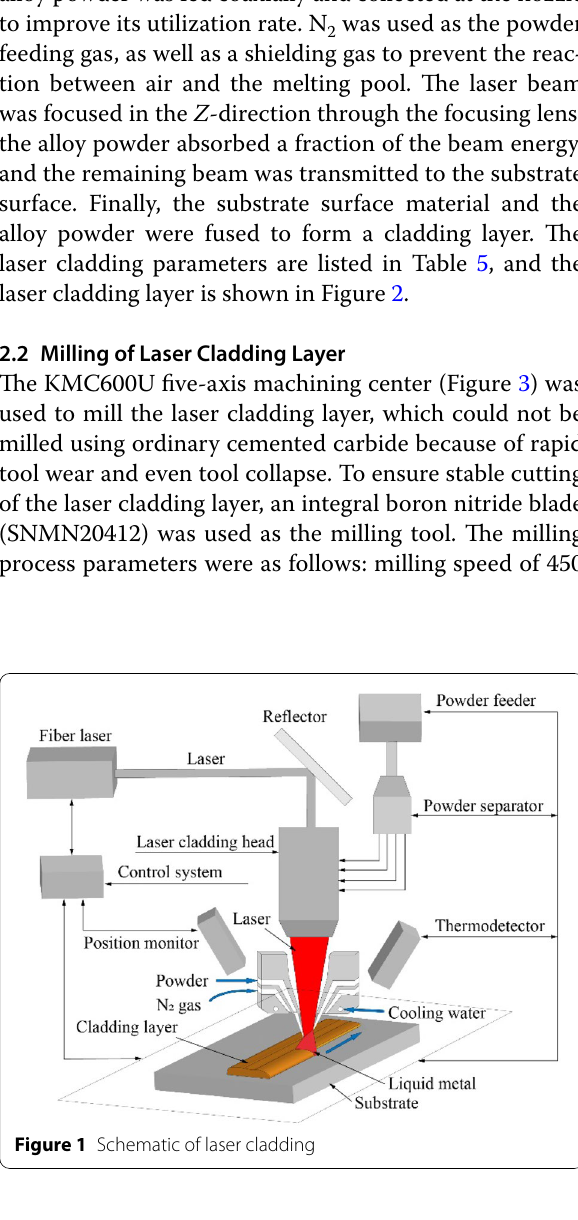
Table 4 Physical properties of iron-based powder Apparent density(g/cm 3 )